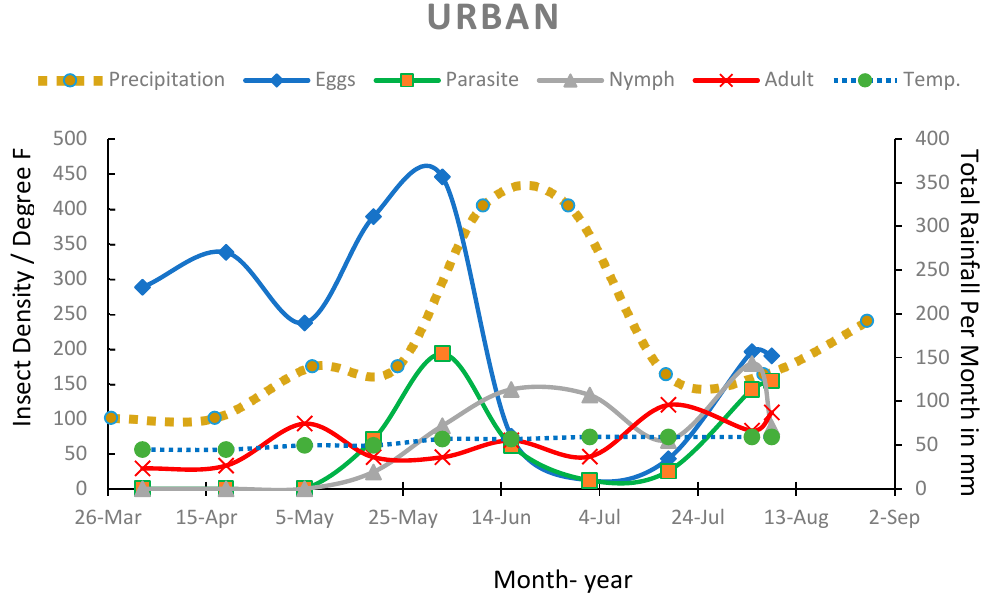
Figure 6. Population dynamics of M. cribraria and P. saccharalis for most active urban site in 2017. Host plant: Pueraria montana (kudzu).